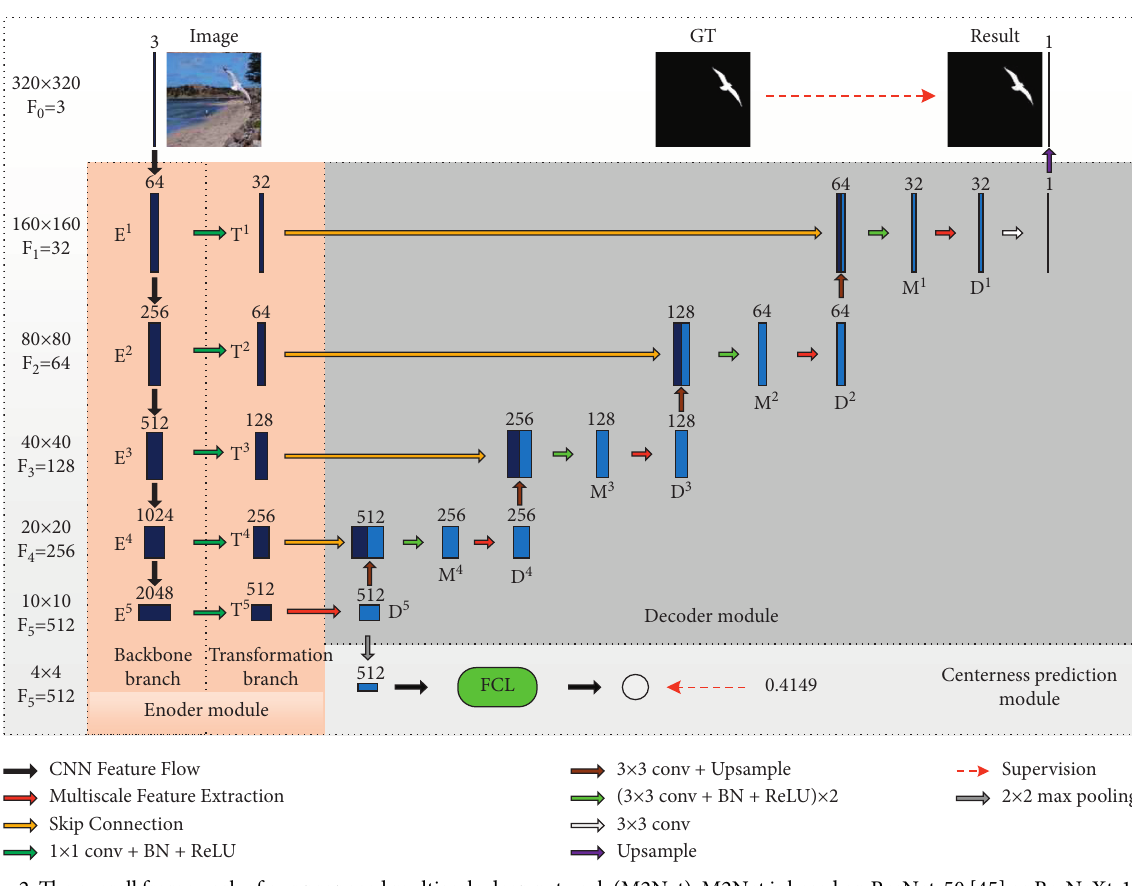
Figure 2: The overall framework of our proposed multiscale deep network (M2Net). M2Net is based on ResNet-50 [45] or ResNeXt-101 [46] with supervision from saliency map and object position. M2Net consists of the backbone branch, transformation branch, decoder branch, and centerness prediction branch. The backbone network is used to extract some important saliency features, the transformation part is used to generate robust saliency features, the decoder part is used to generate the final saliency maps, and the last part is used to predict object position in an